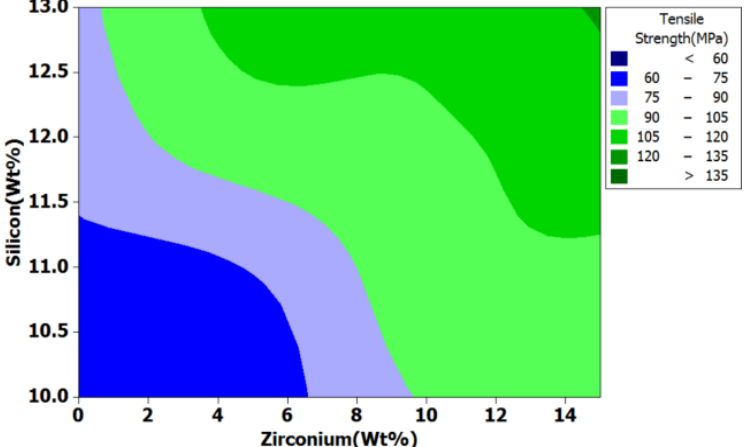
Figure 20. Tensile strength interaction plot.